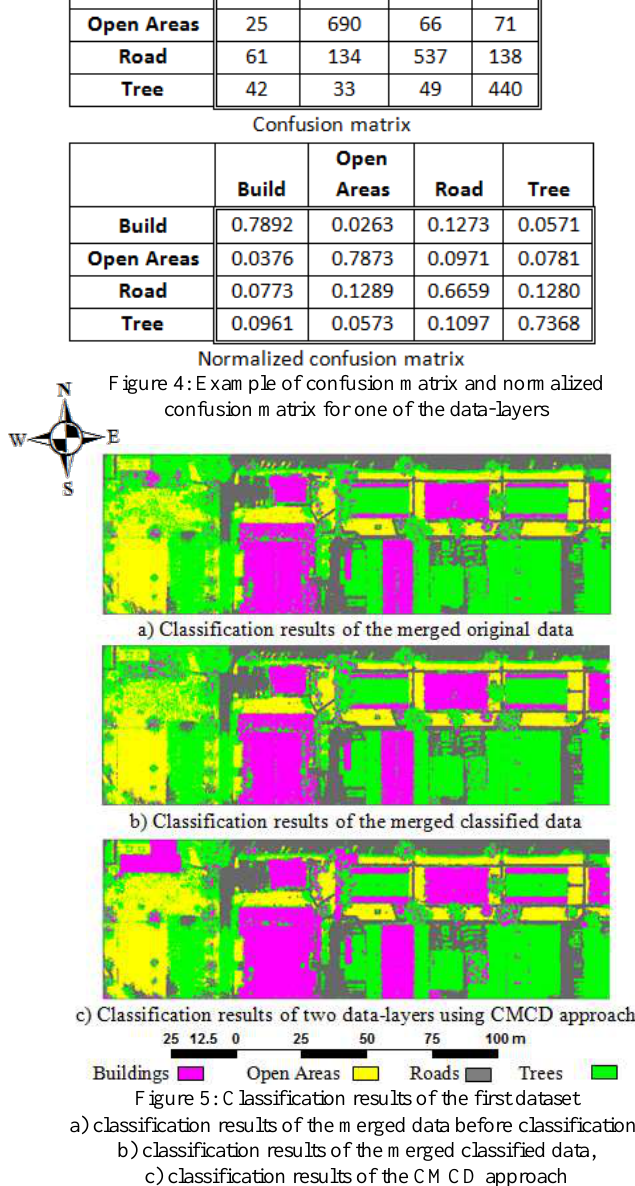
Figure 5: Classification results of the first dataset a) classification results of the merged data before classification, b) classification results of the merged classified data, c) classification results of the CMCD approach